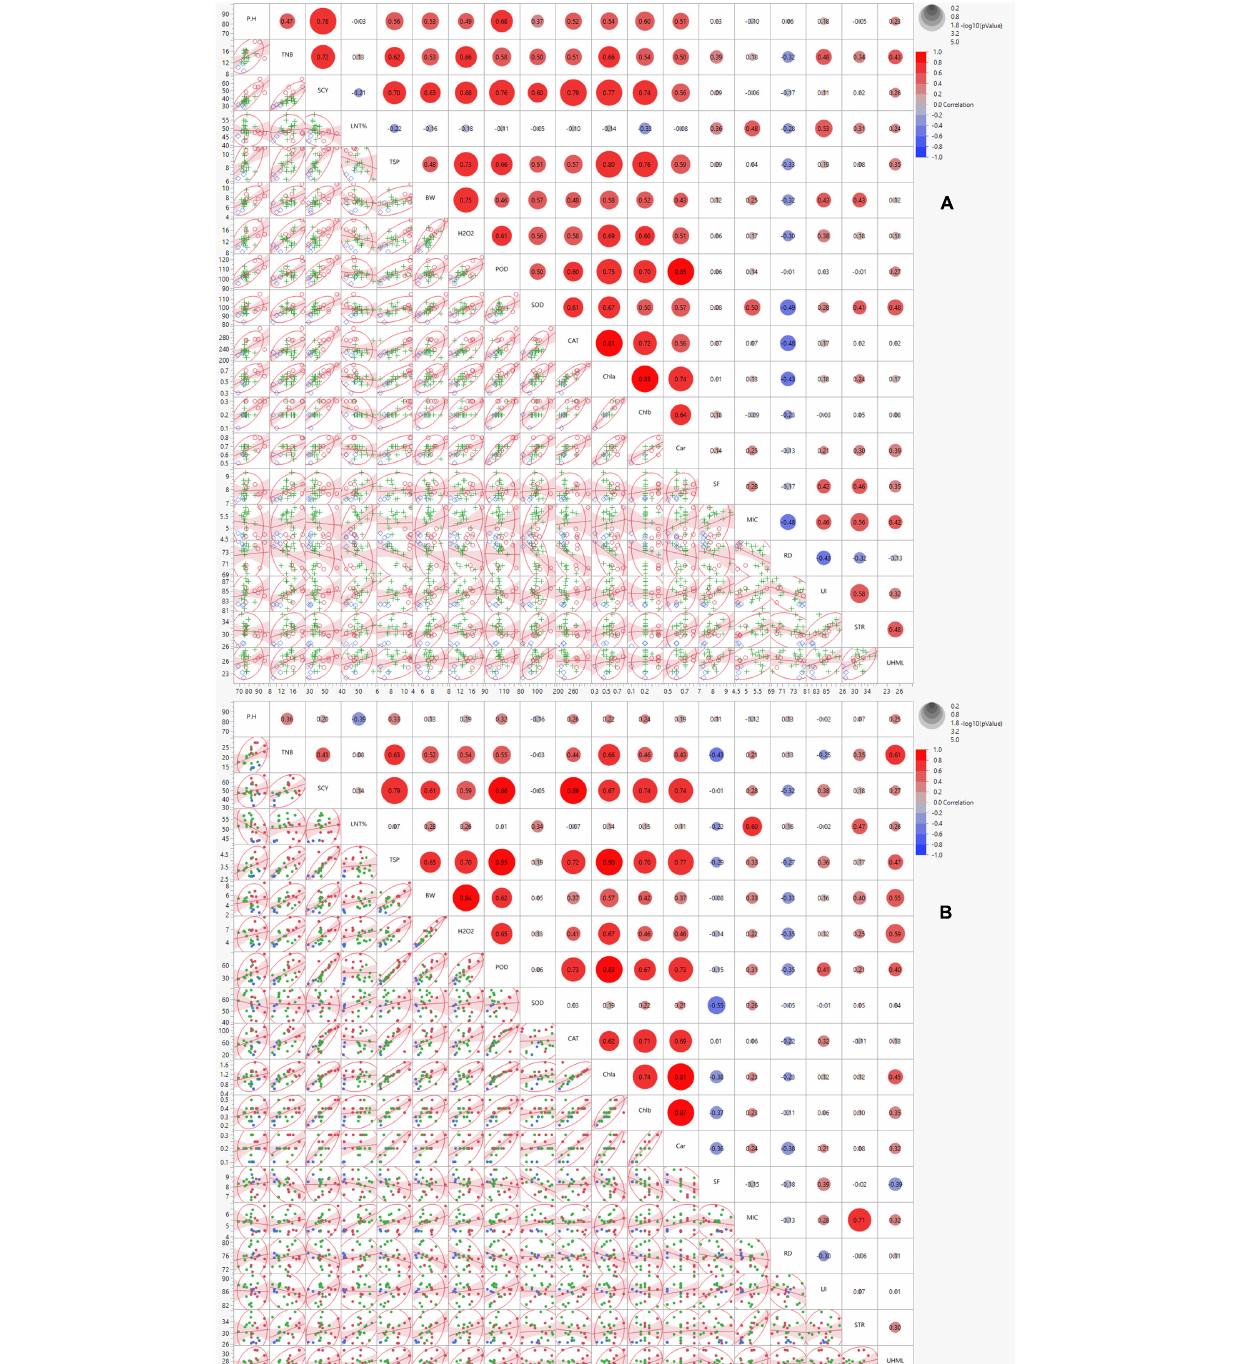
Frontiers in Plant Science |